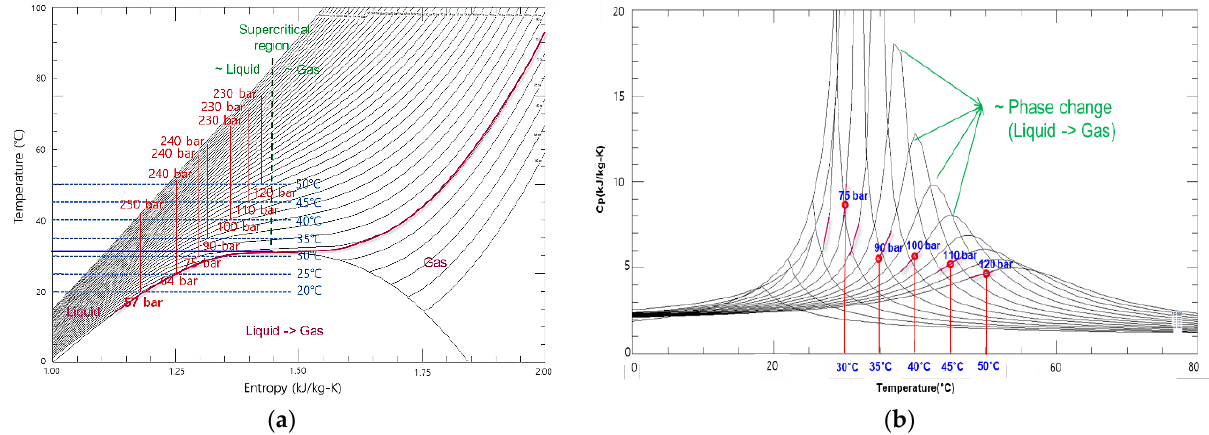
Figure 5. Optimal operating condition and performance of S-CO 2 power cycle for given cooling temperature: ( a ) HR, cycle, and system efficiency; ( b ) low- and high-pressure sides.